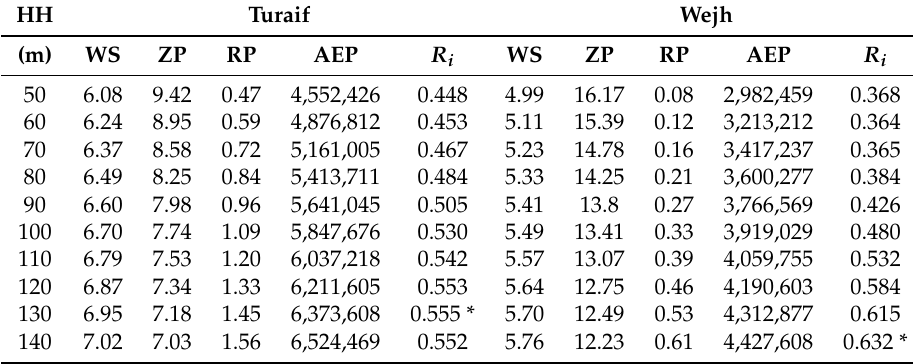
Table A9. TOPSIS analysis for turbine Hanjin HJWT2000-93. The best choice for each site is marked with an